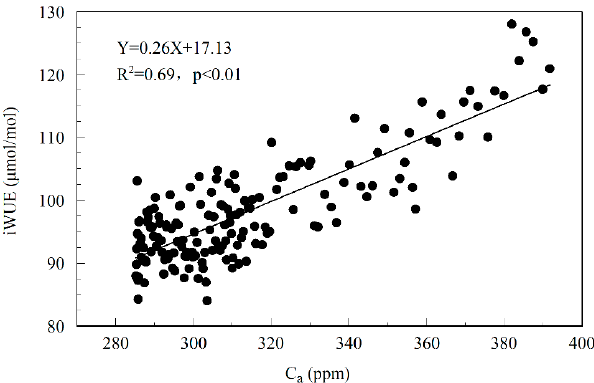
Figure 6. Scatter diagram of the relationship between iWUE and atmospheric CO 2 concentration (C a ). The straight line represents the change trend. The regression equation, explained variance, and level of significance are also shown.